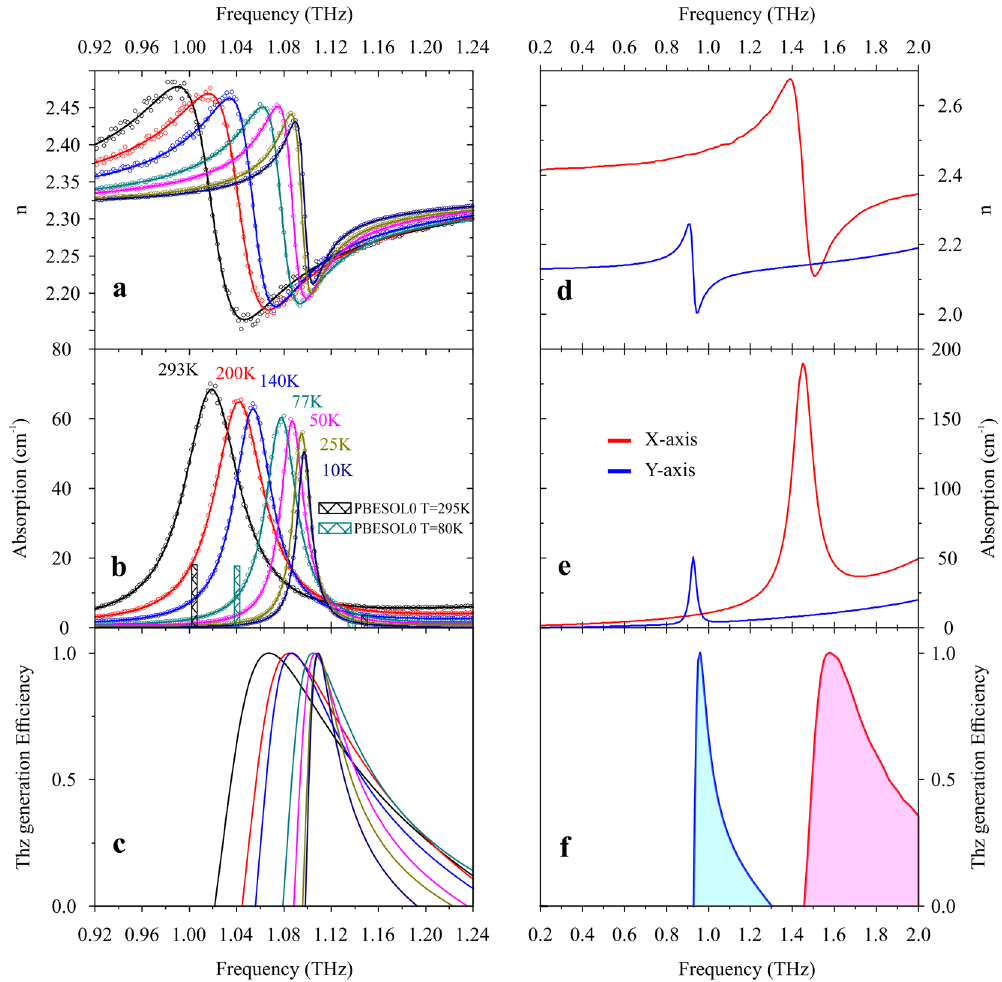
Figure 4. ( a , b ) THz spectra of the absorption and refraction coefficients for Z-mode at different temperatures. Dots represent experimental data. Solid curves indicate the results of the modeling. The columns correspond to the results of the DFT simulation. ( c ) Simulated normalized generation spectra of terahertz radiation in GUHP crystal for the Z axis at different temperatures. ( d , e ) THz spectra of the absorption and refraction coefficients for the X and Y axes at room temperature. The experimental data presented earlier was approximated by the chosen phonon-resonance model for dielectric permittivity. ( f ) Simulated normalized generation spectra of terahertz radiation in GUHP crystal along X and Y axes at room temperature.